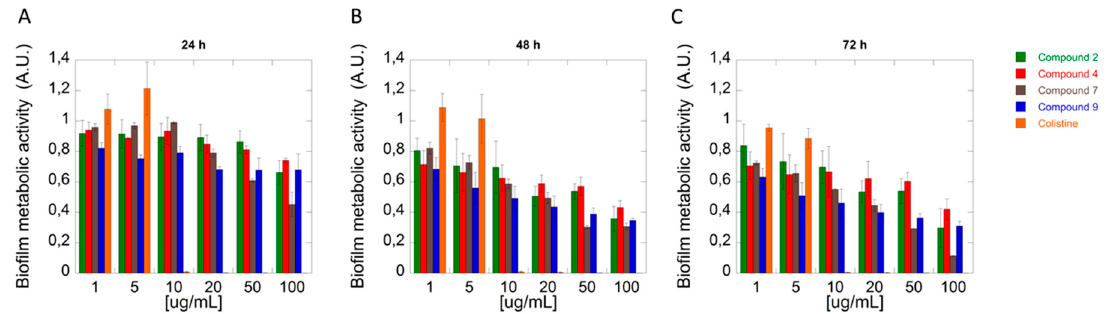
Figure 4. Anti-biofilm activity of phenylselenium-substituted steroids against P. aeruginosa strain. Ability of phenylselenium-substituted steroids to prevent biofilm-formation of P. aeruginosa after 24, 48 and 72 h. Results from 3 measurements ±SD.